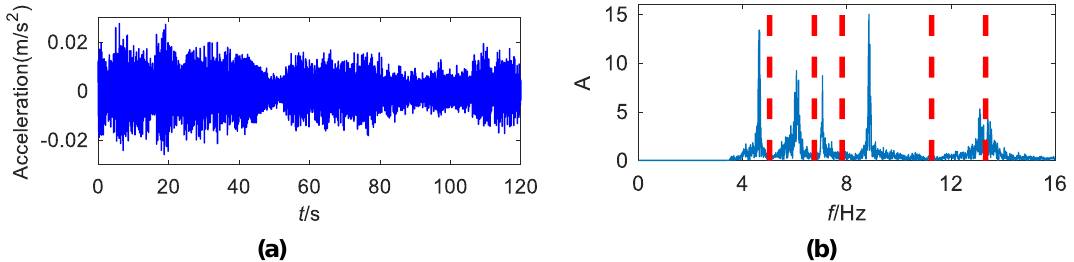
Figure 15. ( a ) The time history of the analyzed acceleration from DHF; ( b ) the detected boundaries in the Fourier spectrum.